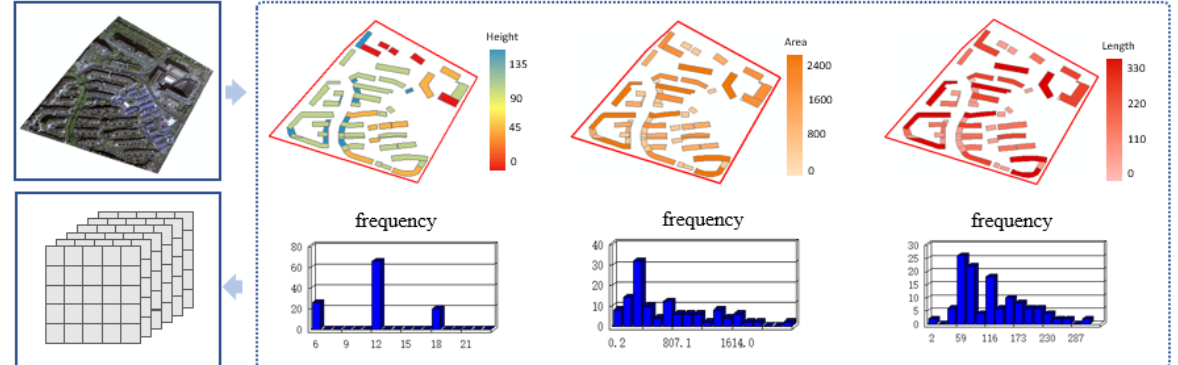
Figure 6. Generation of the footprint feature tensor.